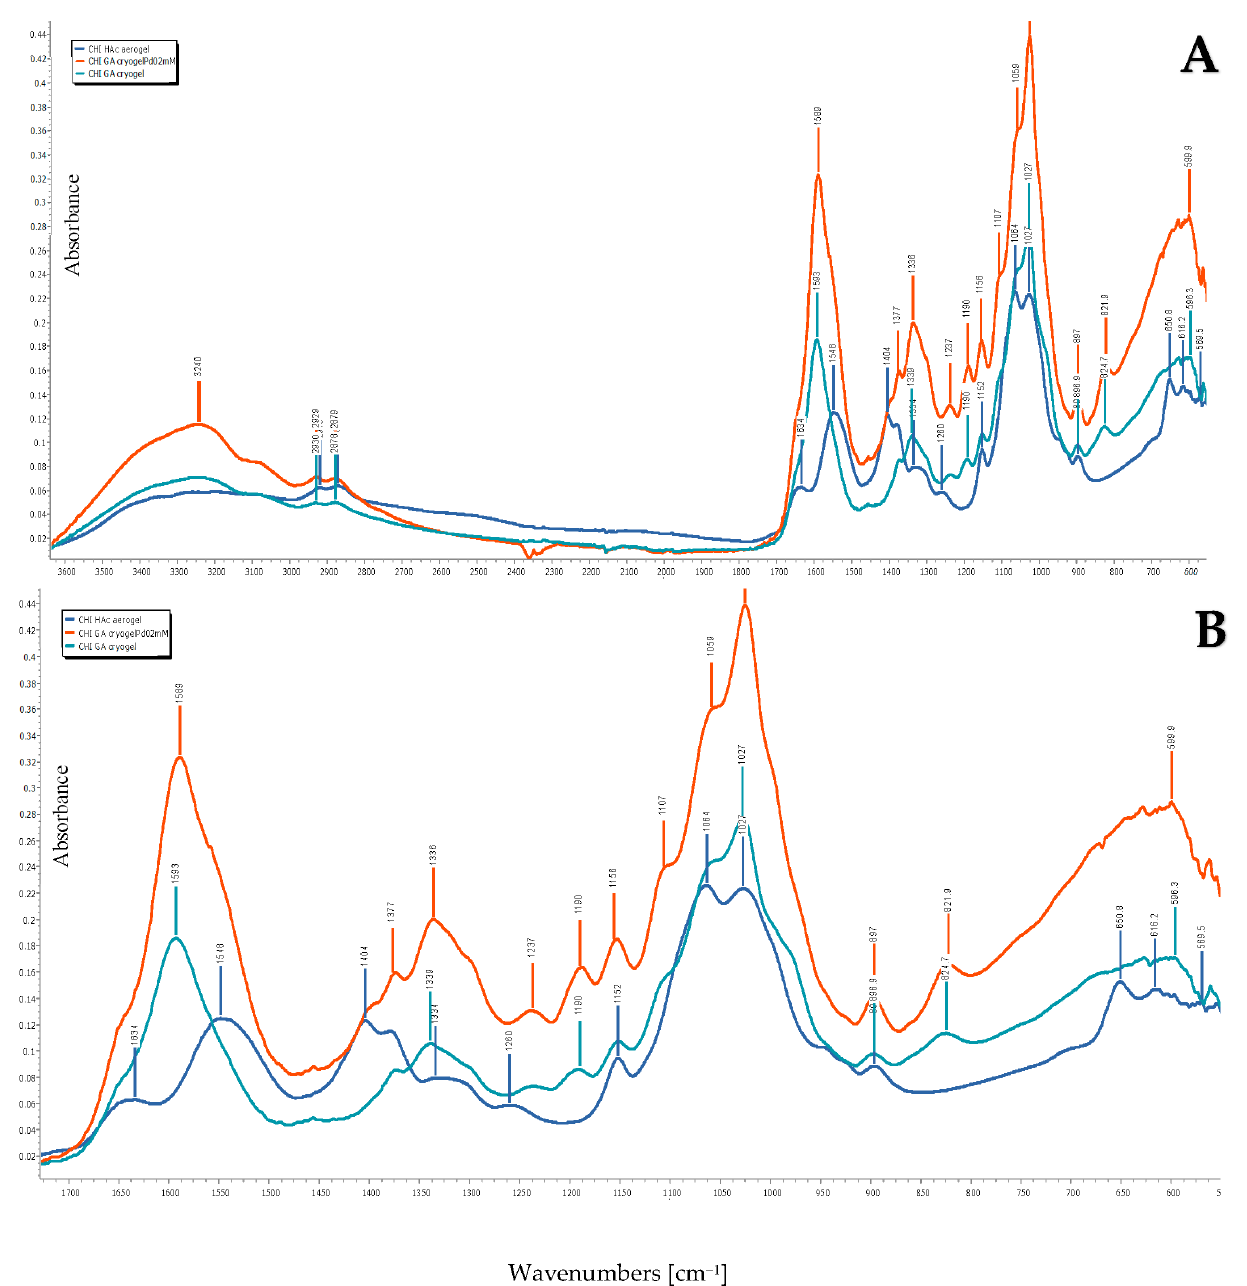
Figure 6. FTIR spectra of freeze dried cryogels CHI-GA-PdNPs 0.2 mM; cryogels CHI-GA and CHI dissolved in acetic acid in the wavenumber range of: ( A ) 3700–600 cm −1 ; ( B ) 1800–600 cm −1 . dissolved in acetic acid in the wavenumber range of: ( A ) 3700–600 cm − 1 ; ( B ) 1800–600 cm − 1